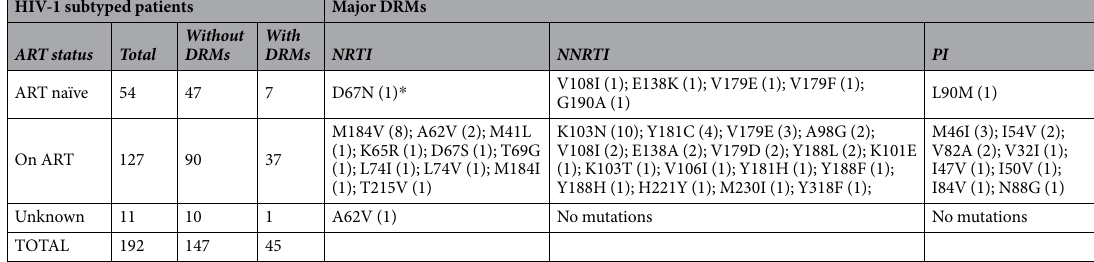
Table 2. Major drug resistance mutations (DRMs) in 192 migrants resident in Italy characterized for the infecting HIV-1 clade. * In parenthesis the number of patients carrying variants with that specific